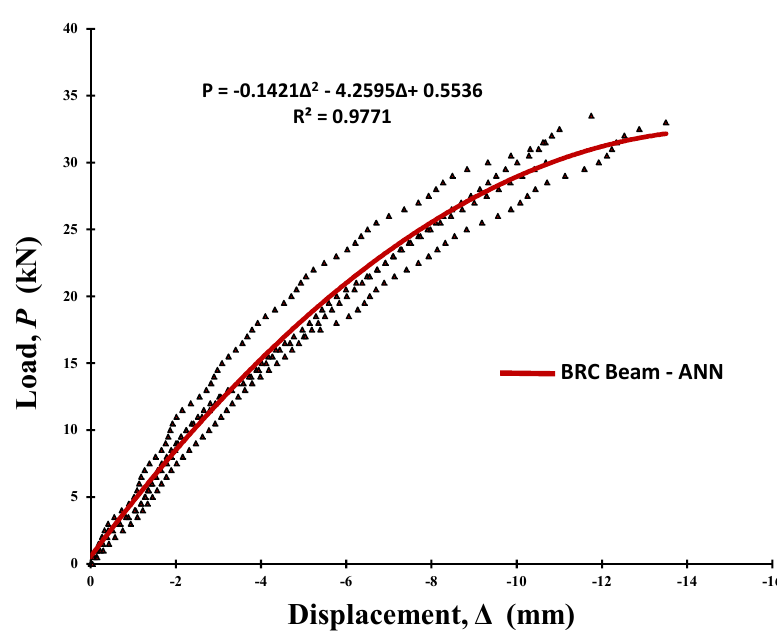
Figure 13. The relationship of load vs. displacement of BRC beam of ANN results.